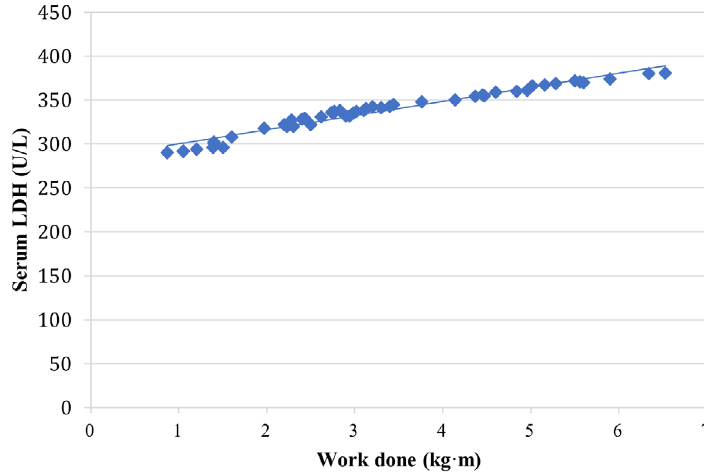
A scatter plot representation of the relation between serum LDH and work done by skeletal muscle in prediabetic males is shown in Figure 3.